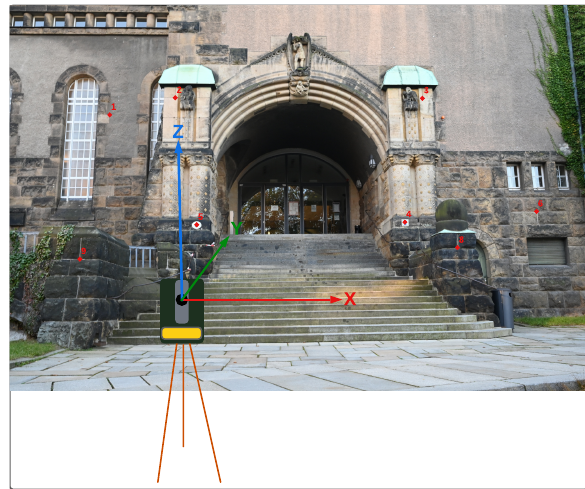
Figure 6. Coordinate system as defined for evaluating the coordinate values for the camera poses. Additionally, 8 out of 10 measured points are marked. One point is left outside (7) and another one top outside (10) the depicted image.